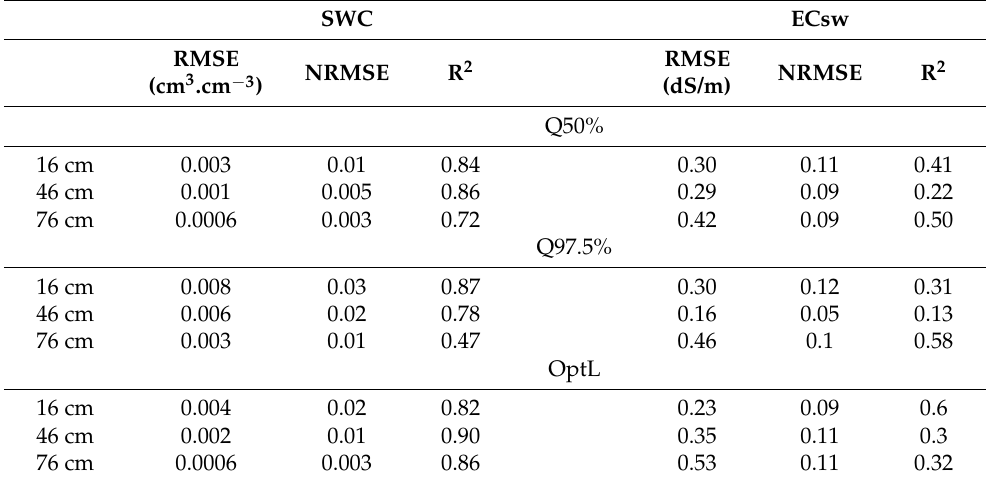
Table 6. Performance of the calibrated HYDRUS-1D model using the GLUE algorithm. SWC ECsw RMSE (cm 3 .cm − 3